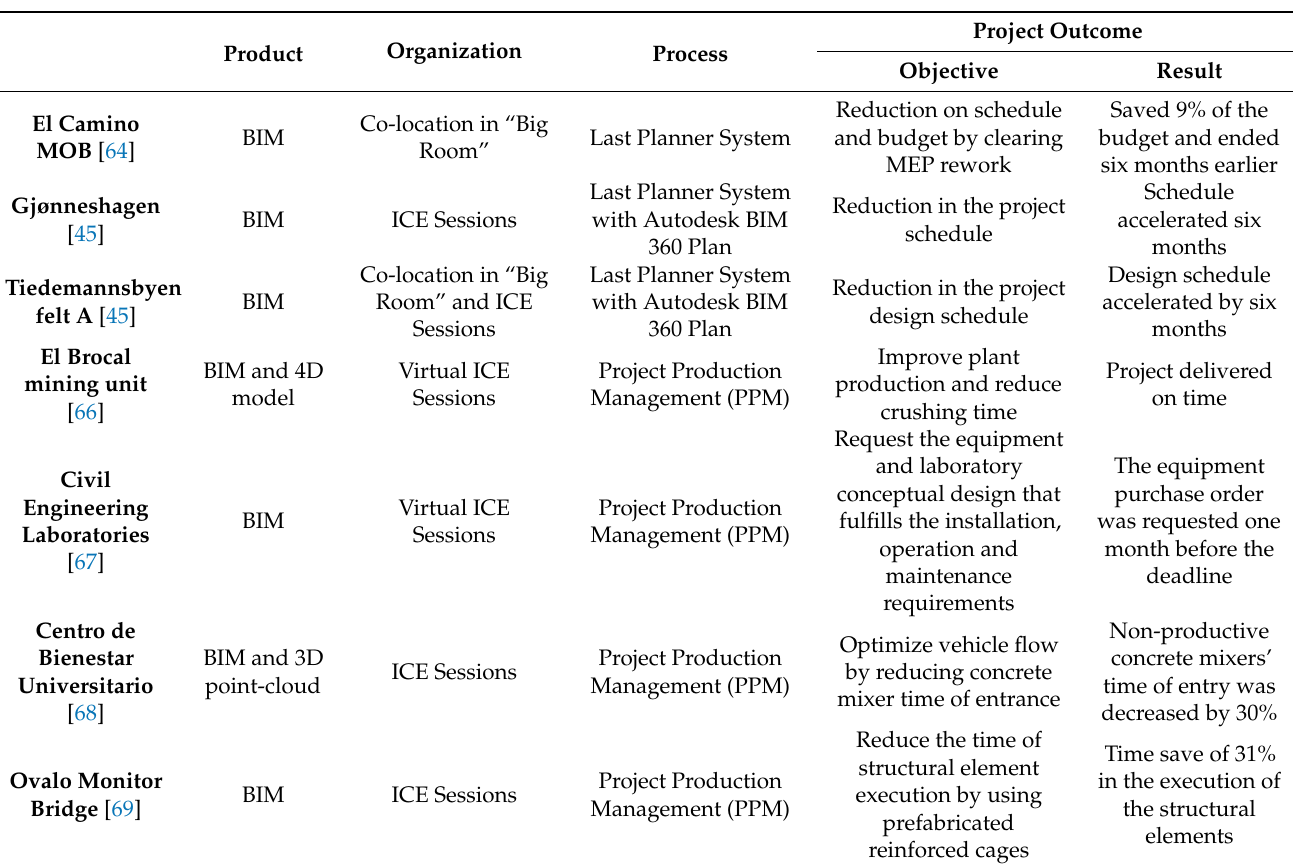
Table 3. VDC elements found in the case